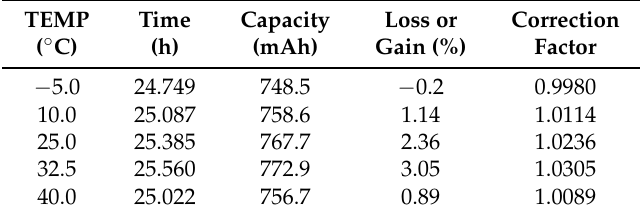
Table 3. Correction Factor (CF) at different